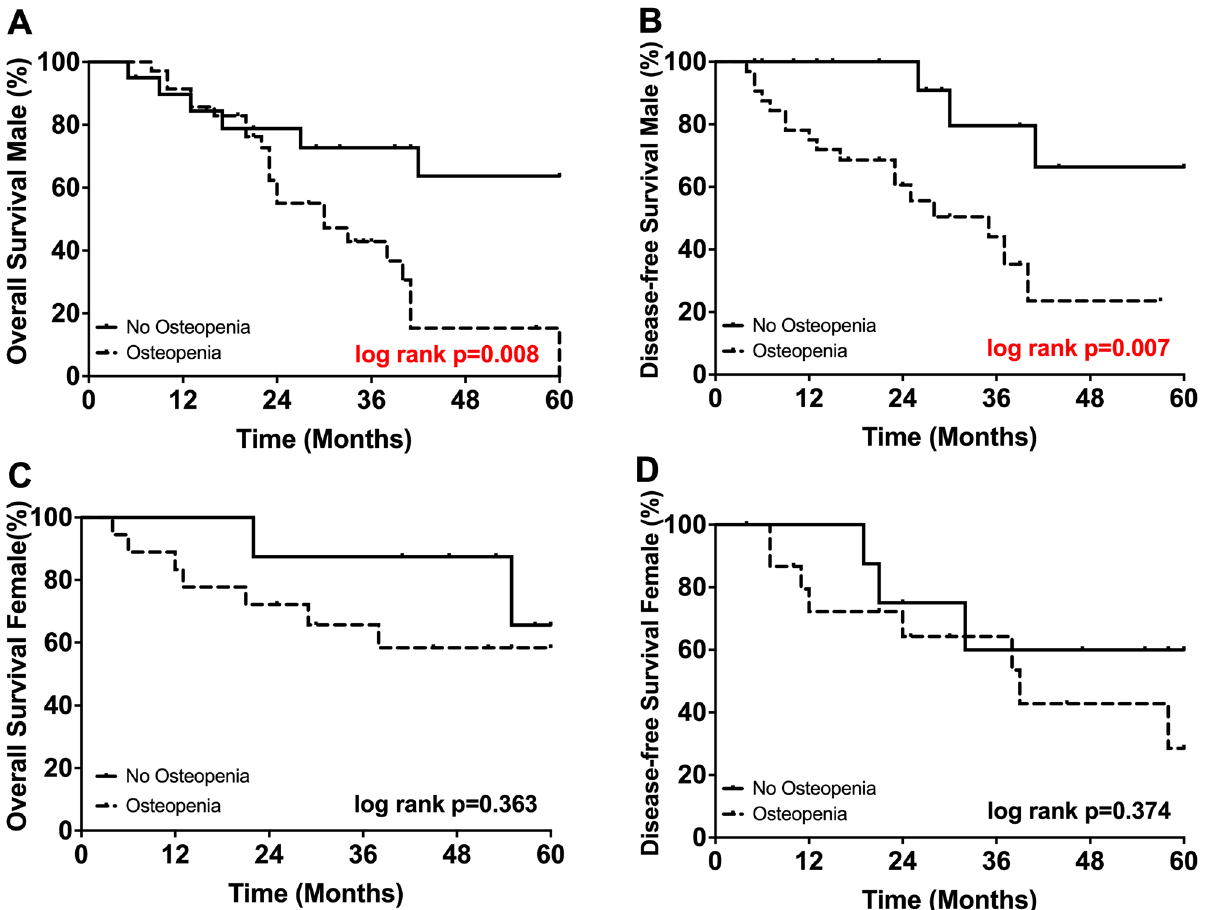
Figure 4. ( A ) 5-year survival of male osteopenic and non-osteopenic patients. ( B ) Disease-free survival of male osteopenic and non-osteopenic patients. ( C ) 5-year survival of female osteopenic and non-osteopenic patients. ( D ) 5-year survival of female osteopenic and non-osteopenic